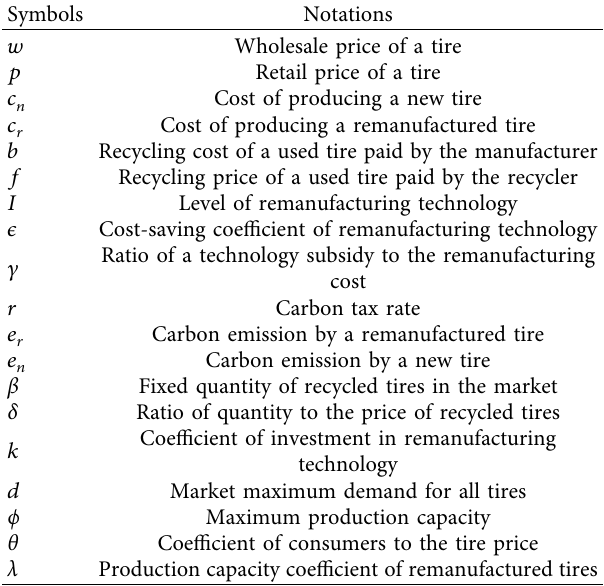
Table 1: Parameters and